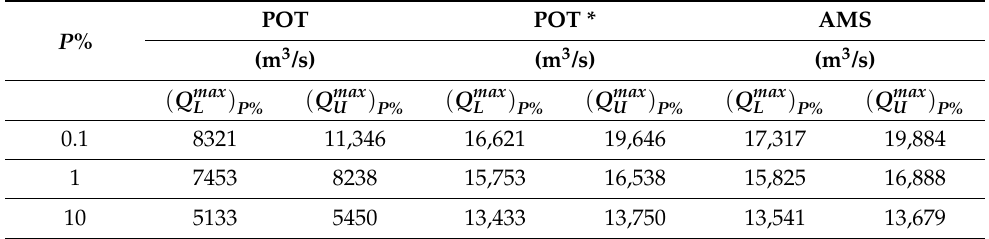
Table 2. Maximum discharges on the Lower Danube, at Turnu-M ă gurele gauge